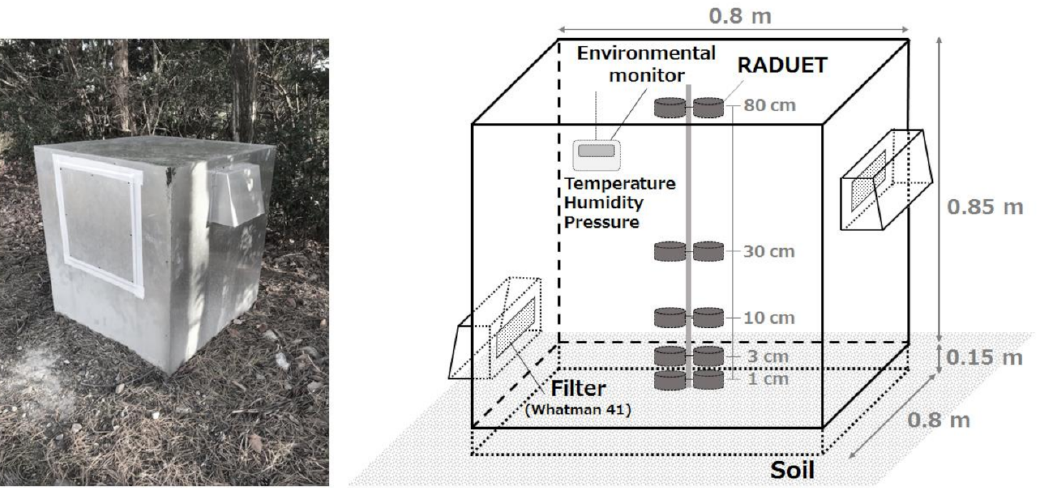
Figure 1. Photo and schematic drawing of the ventilation-type accumulation chamber system for measuring radon and thoron exhalation rates from the